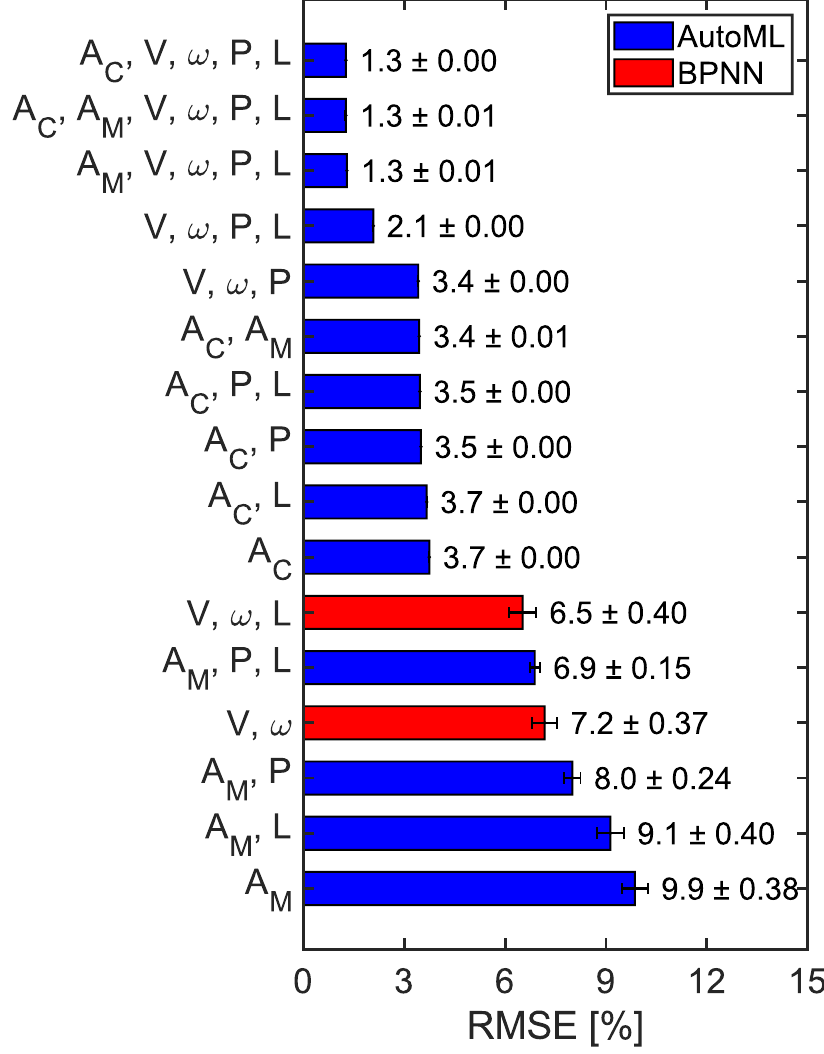
Figure 14. Comparison of the performance of the tire wear prediction with respect to the types of information. The numbers indicate average RMSE errors with plus and minus one standard deviation (A C : acceleration features extracted from the 1D-CNN, A M : manually selected acceleration features, V: wheel travel speed, ω : wheel rotational speed, P: tire internal pressure, L: tire vertical load).